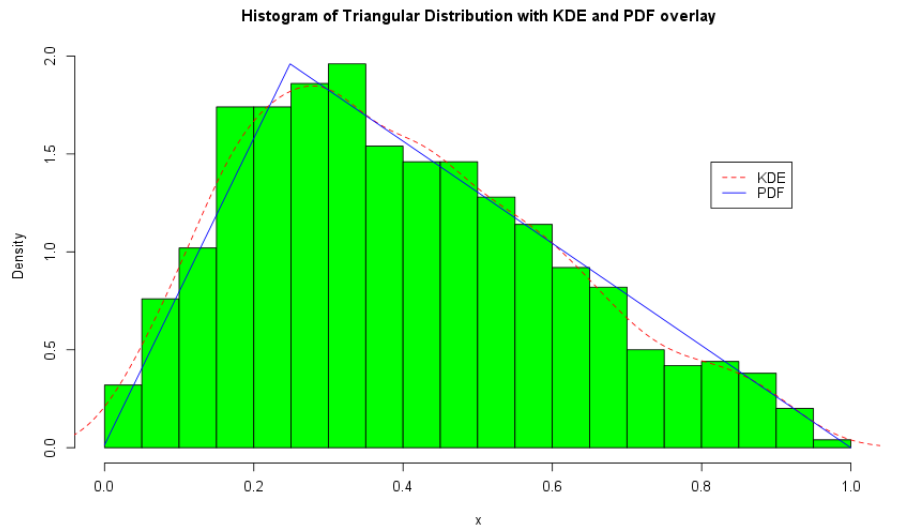
Figure 1. Histogram and density plots of the triangular distribution with θ =